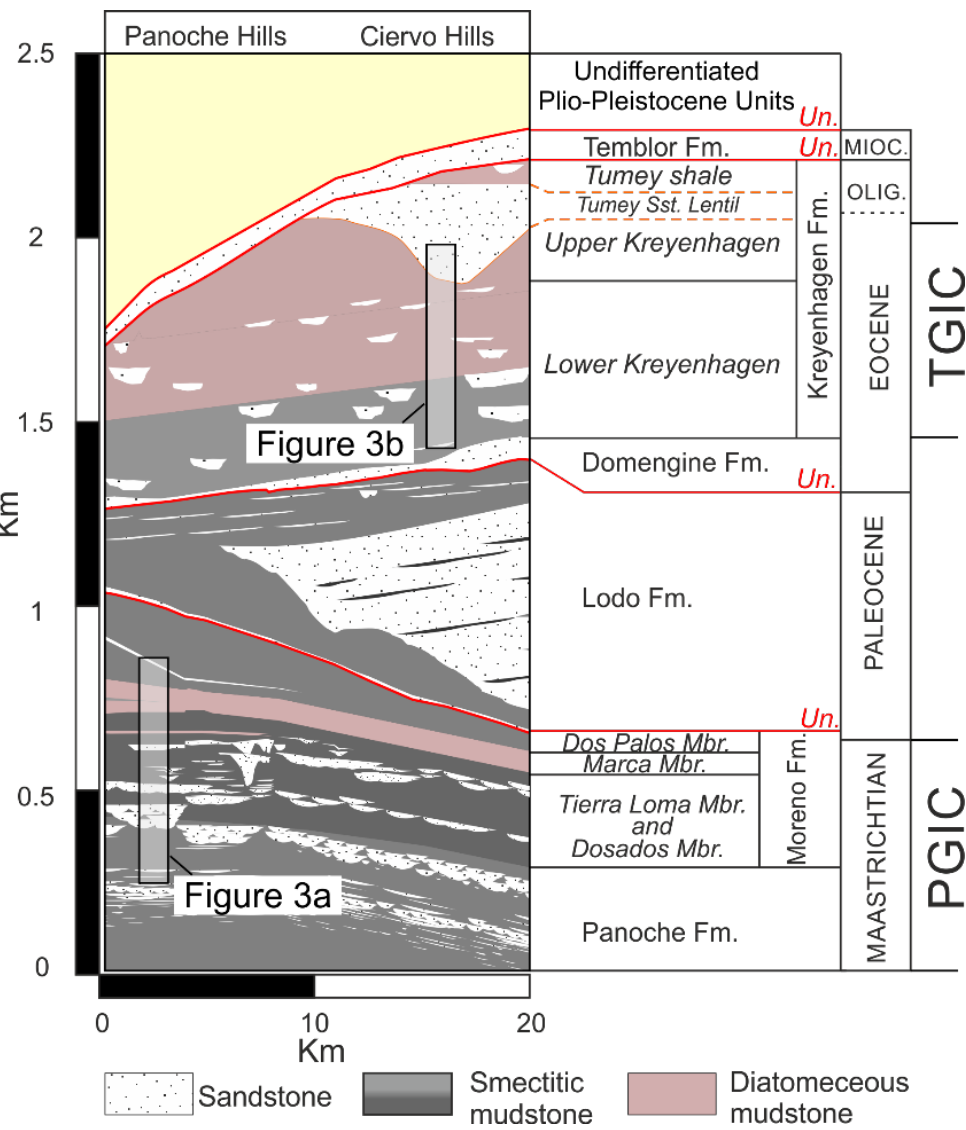
Figure 2. The geological cross-section of the upper part of the Great Valley Sequence in the area from the Panoche to Ciervo hills with locations of Figure 3a,b. The term Un (red) refers to regionally developed unconformities. For simplification, sandstone intrusions are omitted from this figure. Abundant turbiditic sandstone is depicted in the Maastrichtian to Paleogene.